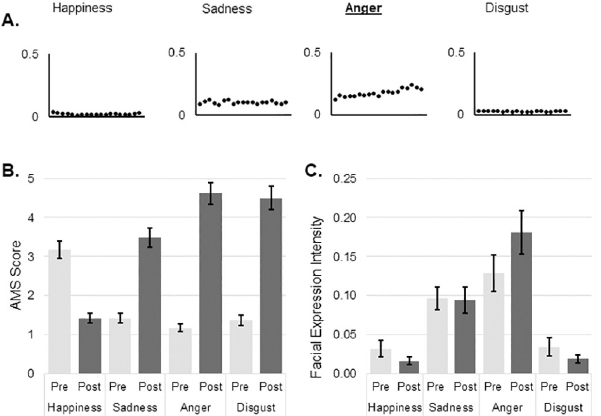
Fig 3. Anger induction. A: Change in mean values of emotions during the course of video as measured by automated facial expression analysis; B: Mean and SE of subjective mood evaluation as measured by AMS; C: Mean and SE of objective mood evaluation as measured by automated facial expression analysis. AMS: Actual Mood State; SE: Standard Error.